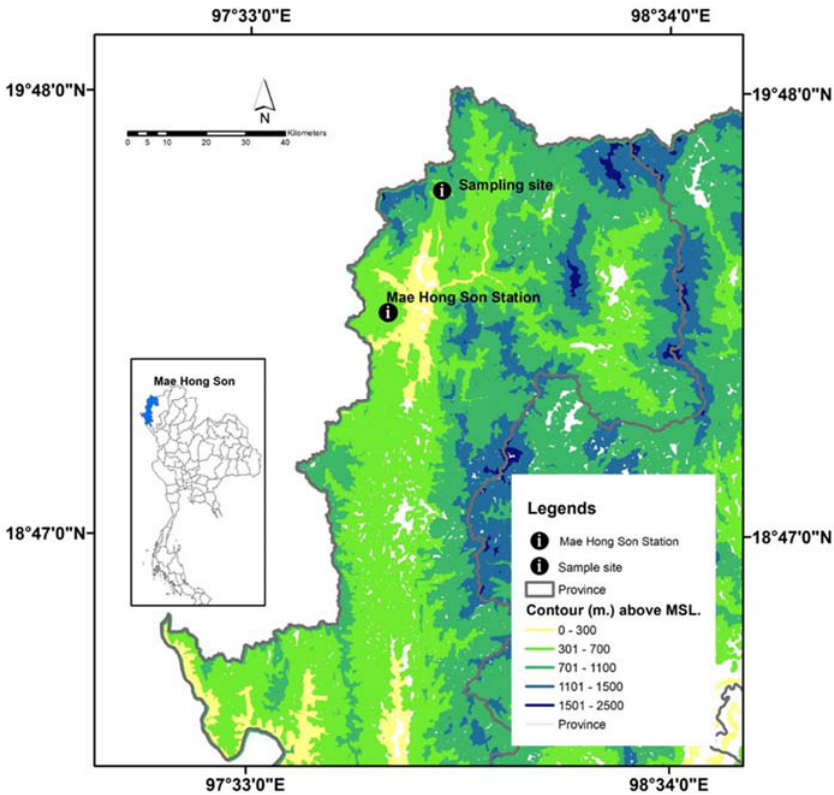
Figure 1. Map of Mae Hong Son province (on the right), Mae Hong Son meteorological station and the study area (black circle). Colors indicate the altitude of the area.